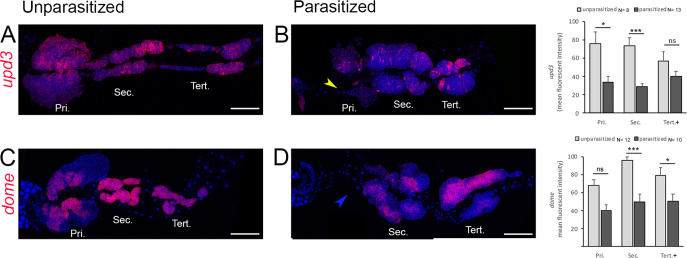
dome and upd3 transcripts are downregulated upon parasitism.Whole lymph gland preparations showing the expression of upd3 (A and B) and dome (C and D) as revealed by RNA in situ in age-matched unparasitized (A and C) and parasitized (B and D) larvae. Graphs representing the mean-fluorescence intensity (MFI) are plotted to the right. Yellow arrowheads indicate histolyzing primary lobes and blue arrowheads indicate histolyzed primary lobes. Error bars represent SEM. Pri. indicates primary lobes, Sec. indicates secondary lobes, and Tert. indicates tertiary lobes. Student's t-test was used for statistical analysis. *p<0.05, **p<0.01, ***p<0.001, and ns indicates nonsignificant. (A–D) Scale bar: 100 µm.Figure 7—figure supplement 1—source data 1.Numerical data plotted related to Figure 7—figure supplement 1.